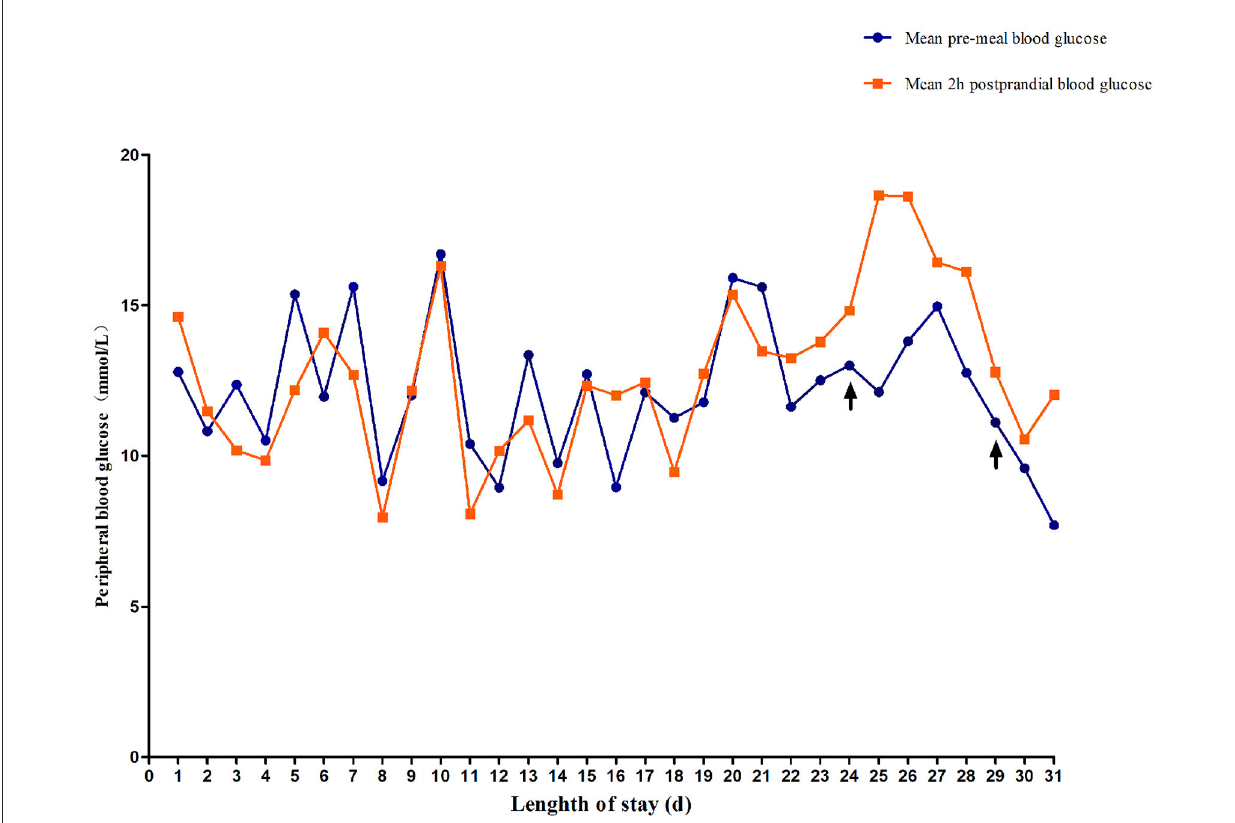
FIGURE2 Changes in fasting blood glucose and 2-h postprandial blood glucose. On day 24, the child was treated with low-dose sulfonylureas (SUs). On day 29, blood glucose fluctuation was reduced by combined treatment with oral SUs and small and frequent meals.